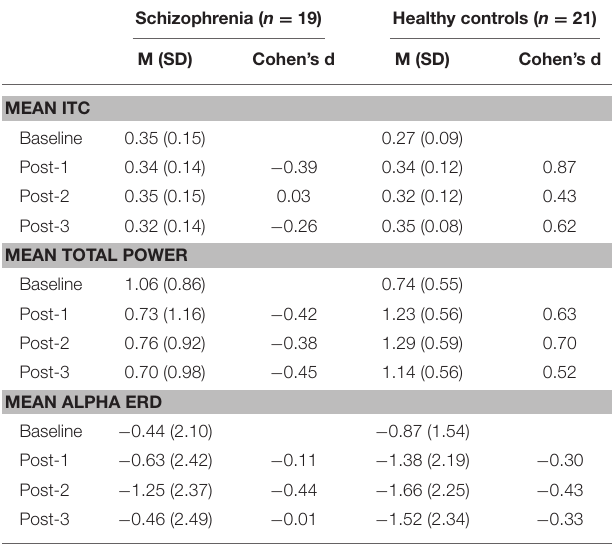
TABLE 2 | Mean (M) and standard deviation (SD) of ITC cluster, total power cluster, and alpha ERD values by